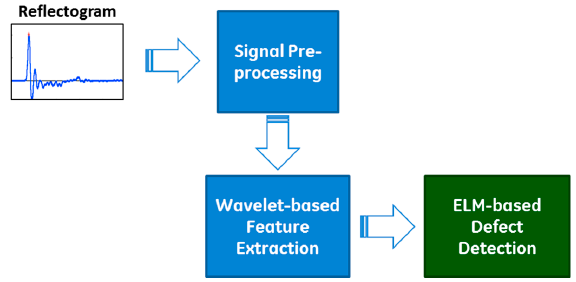
Figure 2. Overall structure of the proposed CARI methodology.